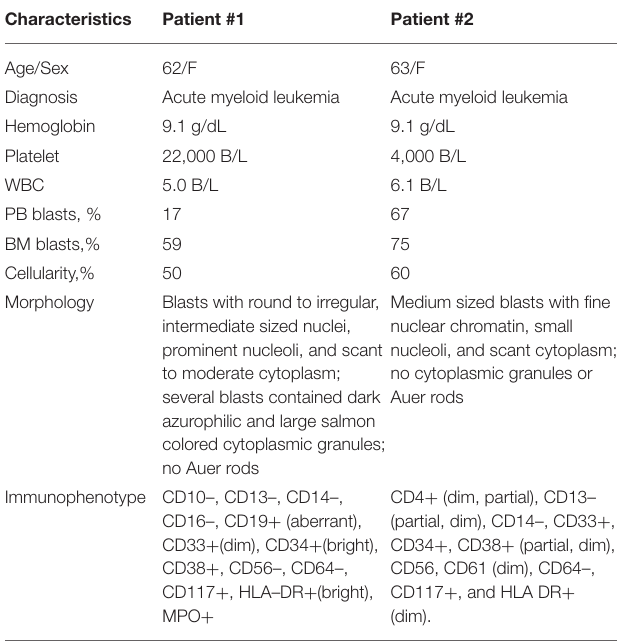
TABLE 1 | Clinicopathologic findings in two patients with variant